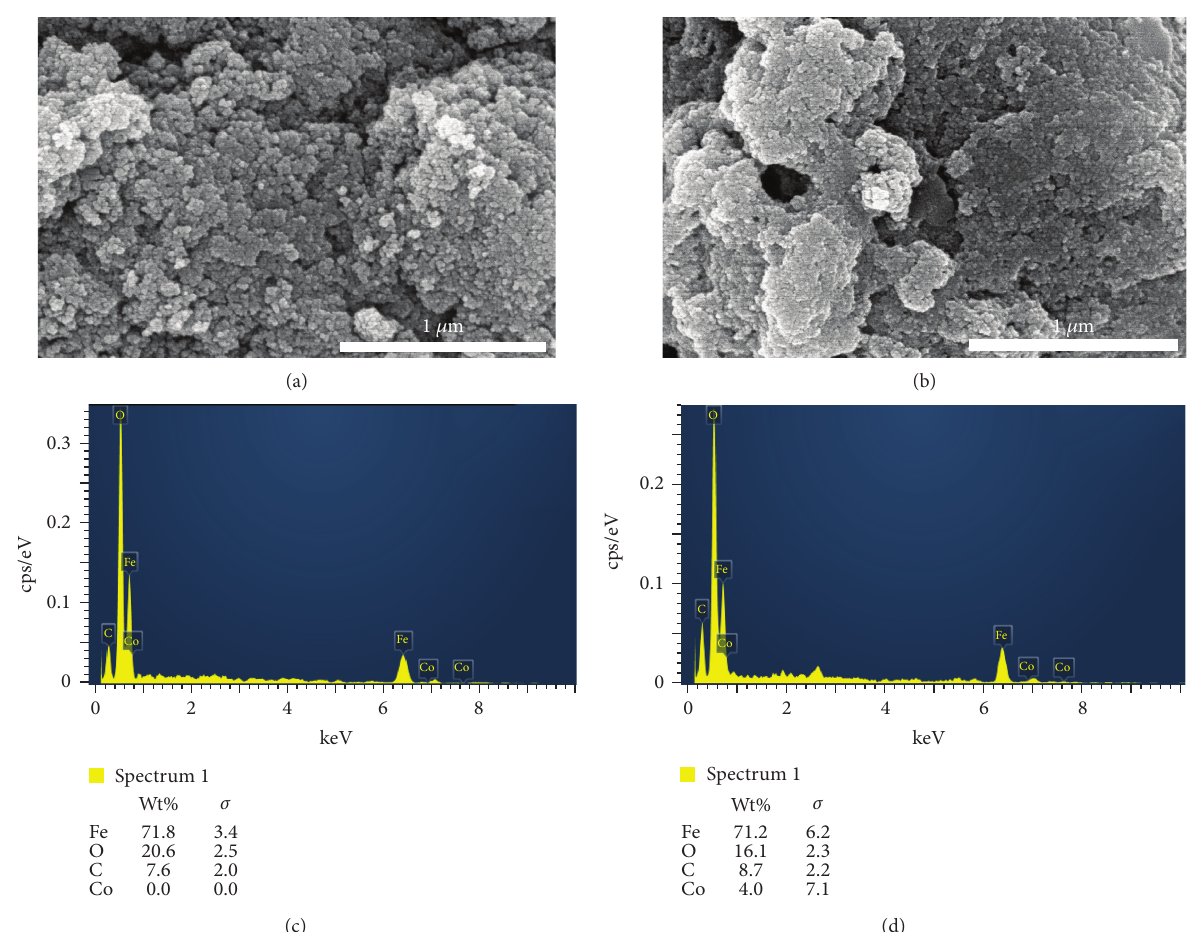
Figure 5: (a, b) SEM and (c, d) EDS spectra of the adsorbent before (a, c) and after (b, d) Co 2+ ion adsorption